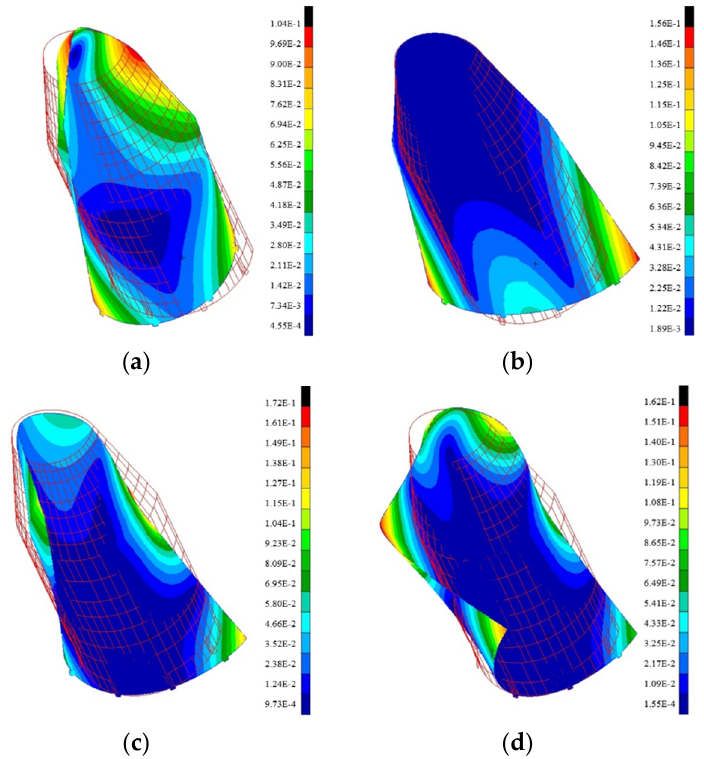
Figure 5. Mode shapes and frequencies. ( a ) First-order mode, 2.2 Hz, ( b ) second-order mode, 5.8 Hz, ( c ) third-order mode, 9.1 Hz, and ( d ) fourth-order mode, 11.5 Hz.